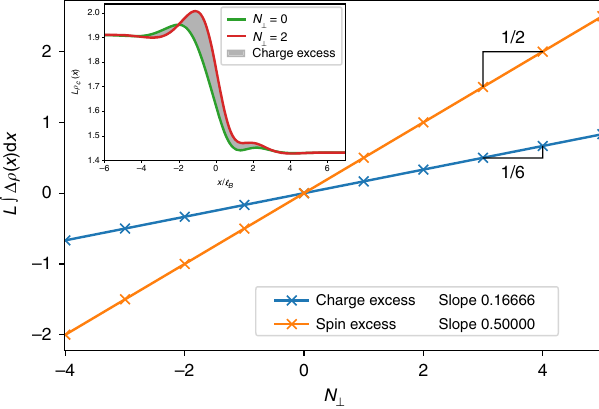
Fig. 4 Spin and charge fractionalization: Charge and spin excess are localized at the interface when excited states are addressed via the MPS boundary U(1) charge N ⊥ . Inset shows how to extract the charge excess (gray shaded area) from the charge densities ρ c at different N ⊥ . Each excess follows a linear relation with extremely good accuracy. The charge (resp. spin) excess has a slope 0.166662(5) ≃ 1/6 (resp. 0.500005(5) ≃ 1/2). This indicates that the elementary excitations of the c = 1 critical theory (cf. Fig. 3) at the interface carry a fractional charge e /6 and a fractional spin 1/2 in unit of the bosonic spin